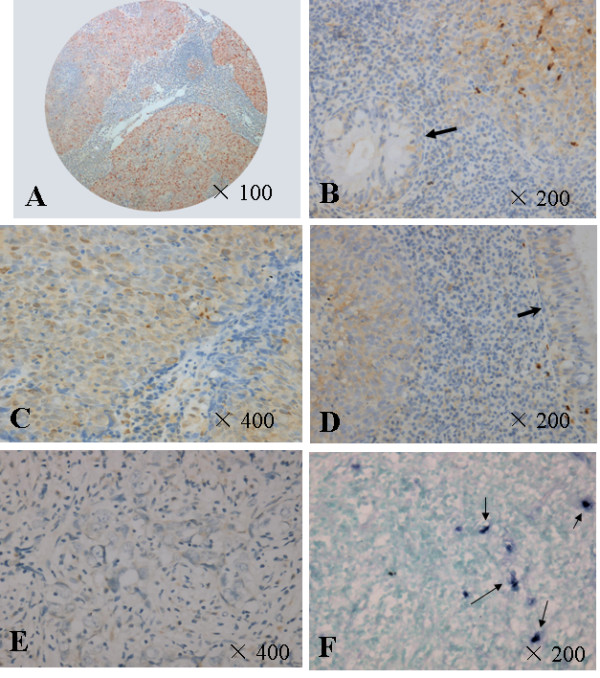
Immunohistochemistry and apoptosis staining of NPC tissue microarray. A. Positive staining of survivin shown under lower power field and B. Cytoplasm positive staining of survivin in the tumor cells and weak staining of the normal epithelium of nasopharynx (arrow directed) C. Strong positive staining of VEGF in tumor cells; D. Cytoplasm positive staining of VEGF in the tumor cells and weak staining of the normal epithelium of nasopharynx (arrow directed); E. Weak staining of survivin in NPC tumor tissues; F. whereas several apoptotic bodies (arrow directed) were observed.